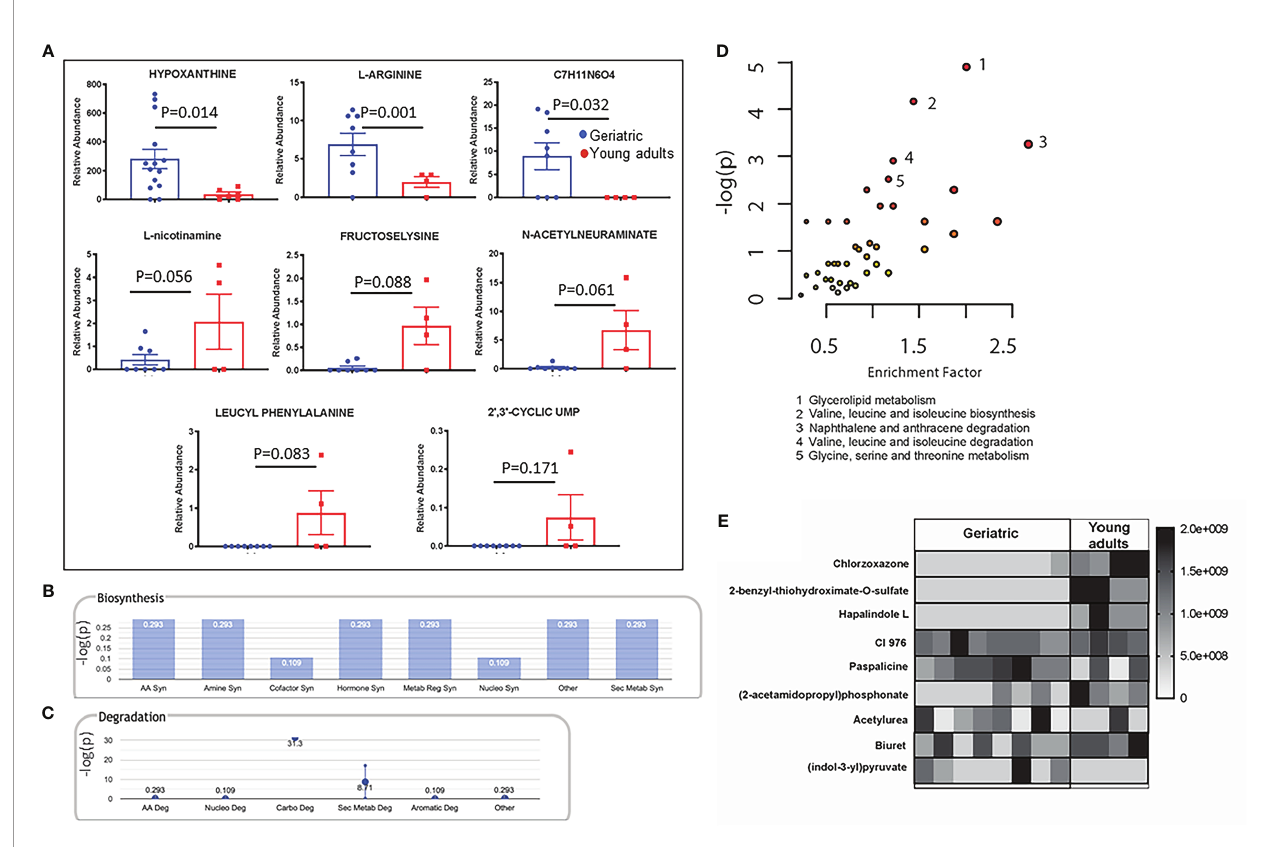
FIGURE 7 | Crosstalk between the bacterial and host metabolic pathways: Mass-spectrometry based Isotope Ratio Outlier Analysis (IROA) showed a few metabolites that were signi fi cantly different between the two groups (A) . Bar graph showing -log(p) enrichment of the biosynthetic and stress pathways in the geriatric animals upon mapping these metabolites on pathways (B) . Enrichment -log(p) of the all degradation pathways with the exception of carbohydrate and secondary metabolite catabolism in geriatric animals (C) . LC-MS/MS analysis of the pure microbial fraction and pathway enrichment analysis showed that glycerolipid, amino acid and secondary metabolite metabolism predominated the metabolic landscape of both groups- Red color signi fi es signi fi cantly enriched pathways in geriatric macaques (D) . Upon mapping the signi fi cantly different metabolites between geriatric and young adult macaques (E) to metabolic pathways, a synchrony was observed between microbial and host biosynthetic and degradation pathways. All metabolites used in the analysis were signi fi cantly different between young adult and geriatric animals (p < 0.05 in Mann-Whitney U test) with FDR of 0.1 (Benjamini-Hochberg